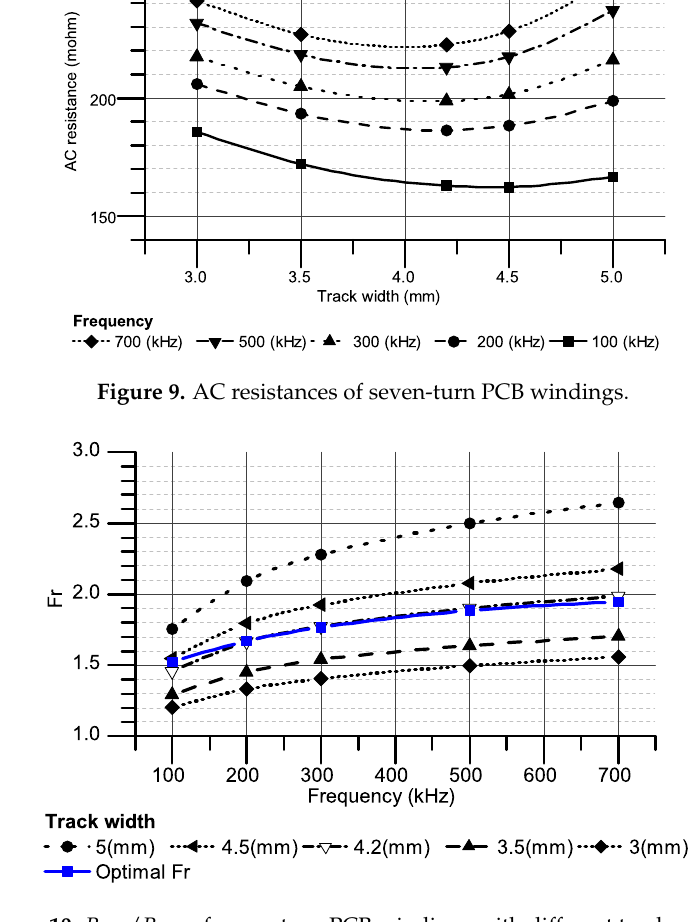
Figure 10. R AC / R DC of seven-turn PCB windings with different track widths.